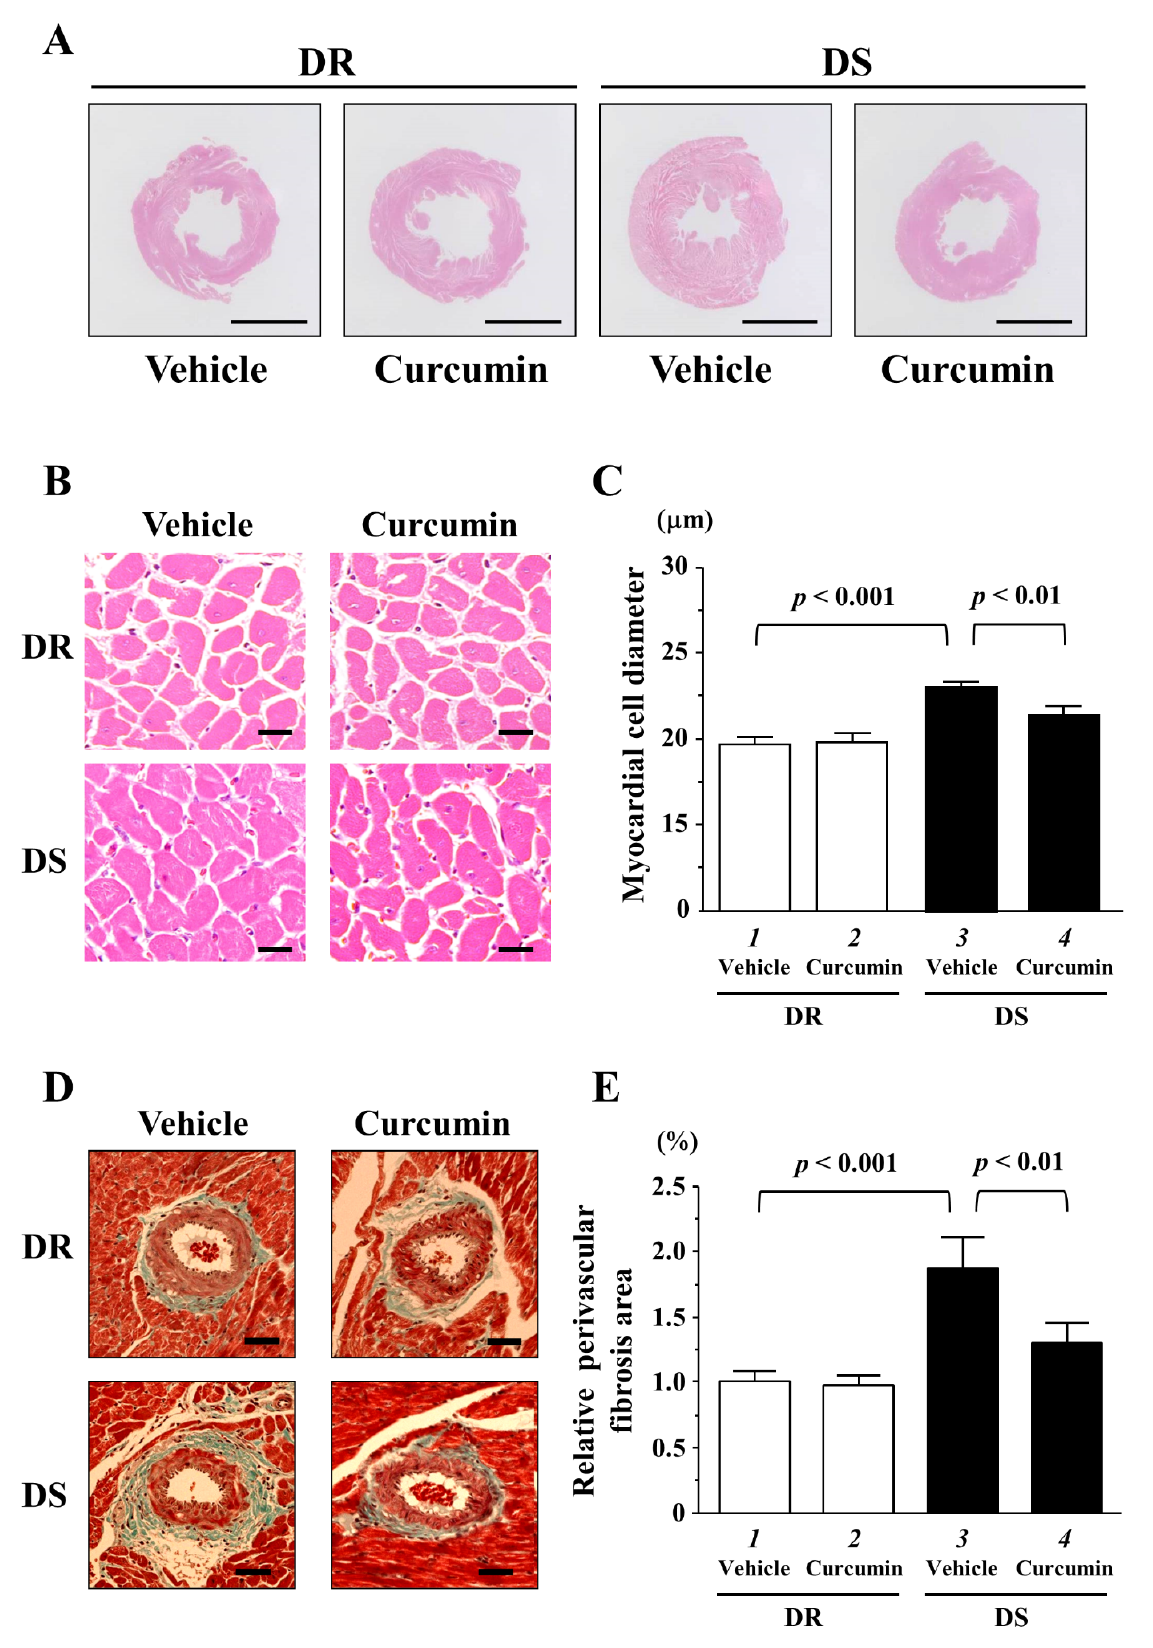
Figure 3. The hemodynamic overload-induced concentric left ventricular hypertrophy (LVH), myocardial cell hypertrophy and perivascular fibrosis were significantly reduced by curcumin treatment in DS rats. ( A ) The representative